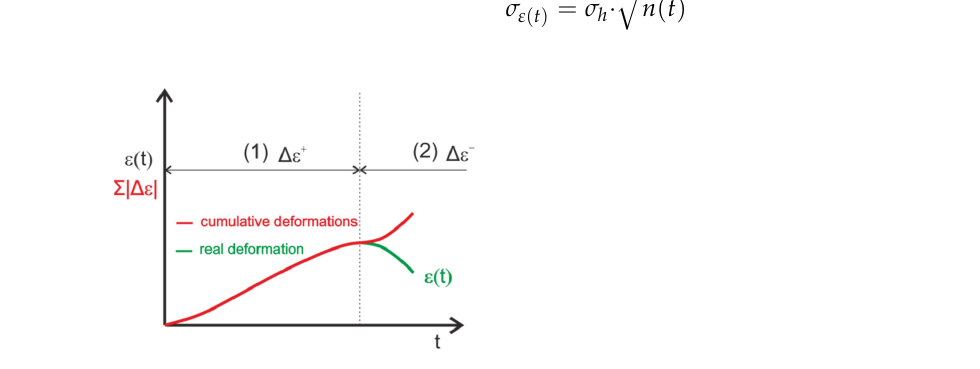
Figure 2. A schematic representation of deformation accumulation over time (own study).